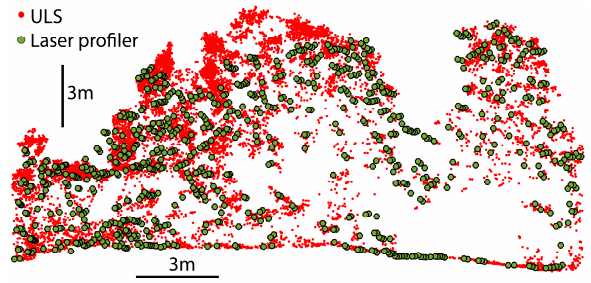
Figure 5: Cross section in vegetated riparian area; laser profiler (green), ULS (red)